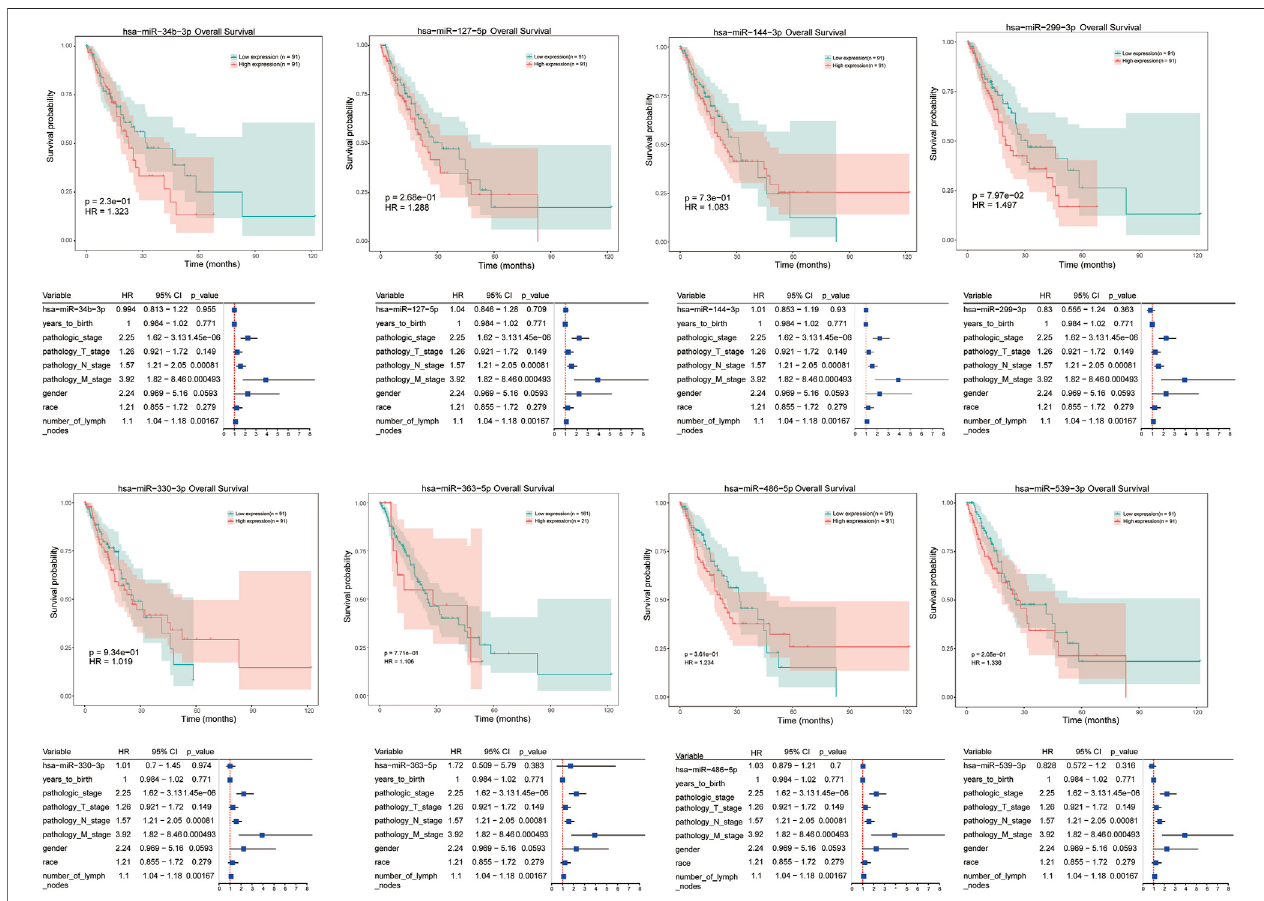
FIGURE 6 | Univariate cox regression analysis and survival analysis for differentially expressed miRNAs in ESCC responder samples, including hsa-miR-34b-3p, hsa-miR-127-5p, hsa-miR-144-3p, etc. The X axis represent overall survival time (month), and Y axis means survival probability. p < 0.05 represent a signi fi cant